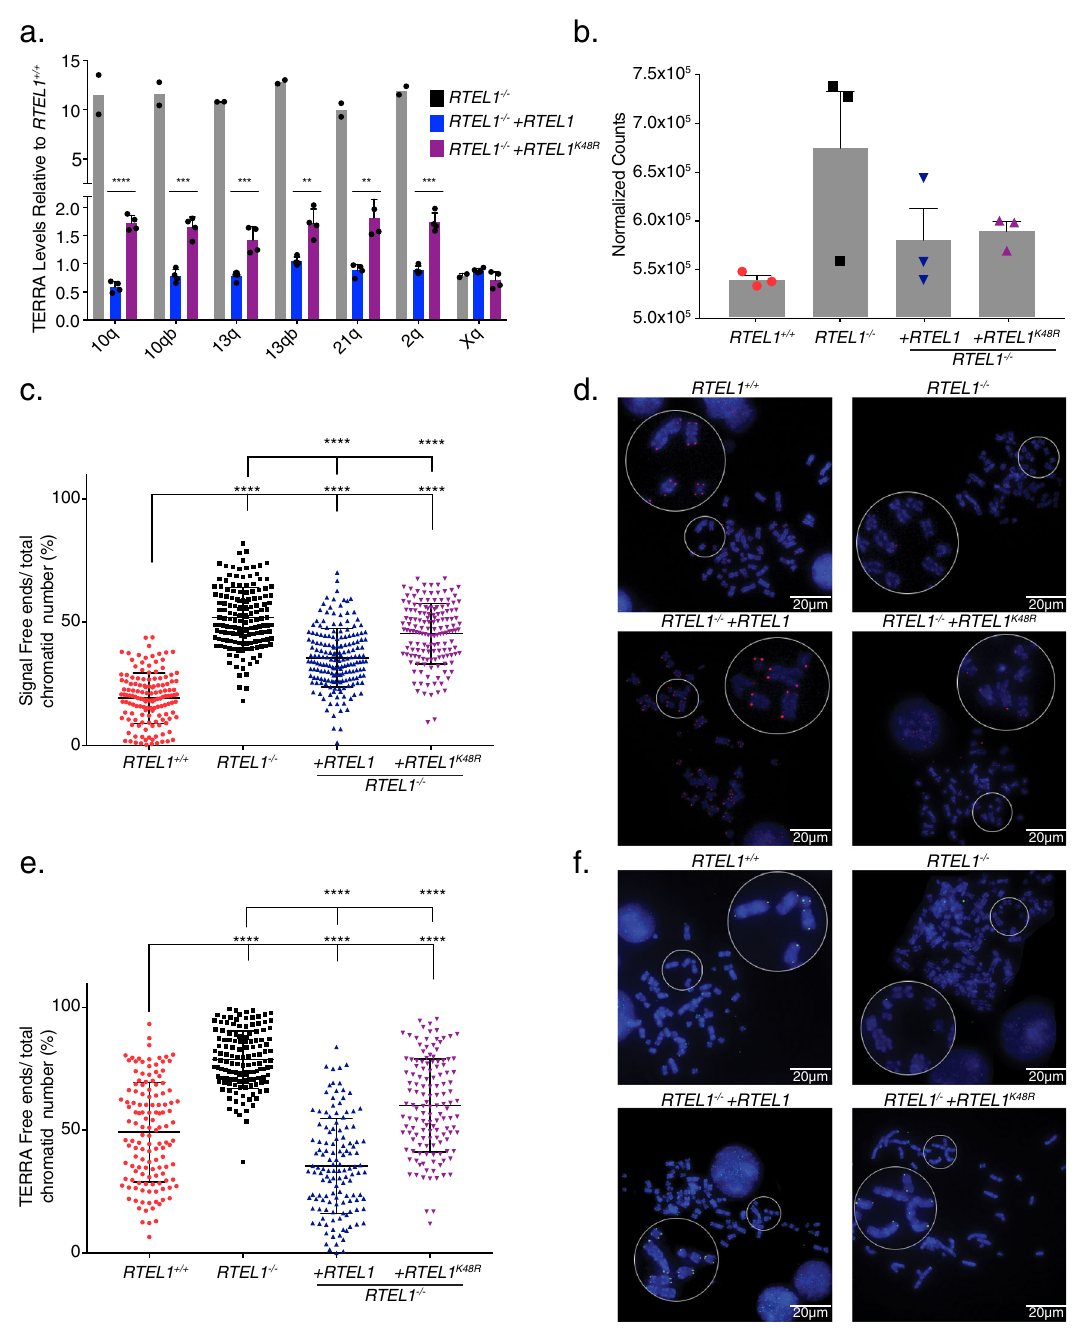
Fig. 4 RTEL1 In fl uences TERRA Localization. TERRA levels are rescued upon RTEL1 complementation. a TERRA levels for four upregulated chromosome ends in the RTEL1-KO cell line were tested in cells complemented with FLAG-RTEL1 and a catalytic site mutant FLAG-RTEL1 K48R . Bars represent the relative TERRA expression measured by qRT-PCR in three independent experiments (* p < 0.05, ** p < 0.01, *** p < 0.001, **** p < 0.0001, two-sided t -test) and mean and standard deviation is shown. b Total subtelomeric counts determined by RNA-seq experiments in the cell lines speci fi ed in a . Mean + / − SEM is shown. c Quanti fi cation of telomere loss per chromatid in FLAG-RTEL1 and FLAG-RTEL1 K48R reconstituted cell lines by telomere FISH. d Representative telomere FISH images are shown with zoomed-in section (large white circle for zoom of small white circle). e Quanti fi cation of TERRA loss per chromatid in FLAG-RTEL1 and FLAG-RTEL1 K48R reconstituted cell lines by TERRA FISH. f Representative TERRA FISH images are shown with zoomed-in section (large white circle for zoom of small white circle). Data for both TERRA and Telomere FISH experiments represent the average of at least 50 metaphases in each of three independent experiments and three independent reconstitutions shown as the mean and standard deviation (* p < 0.05, ** p < 0.01, *** p < 0.001, **** p < 0.0001, two-sided t -test) (see also Supplementary Figs. 8 and